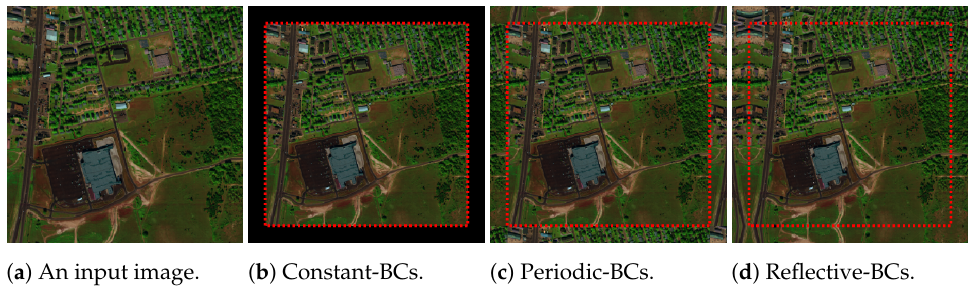
Figure 5. Three types of boundary conditions (BCs) applied on the input